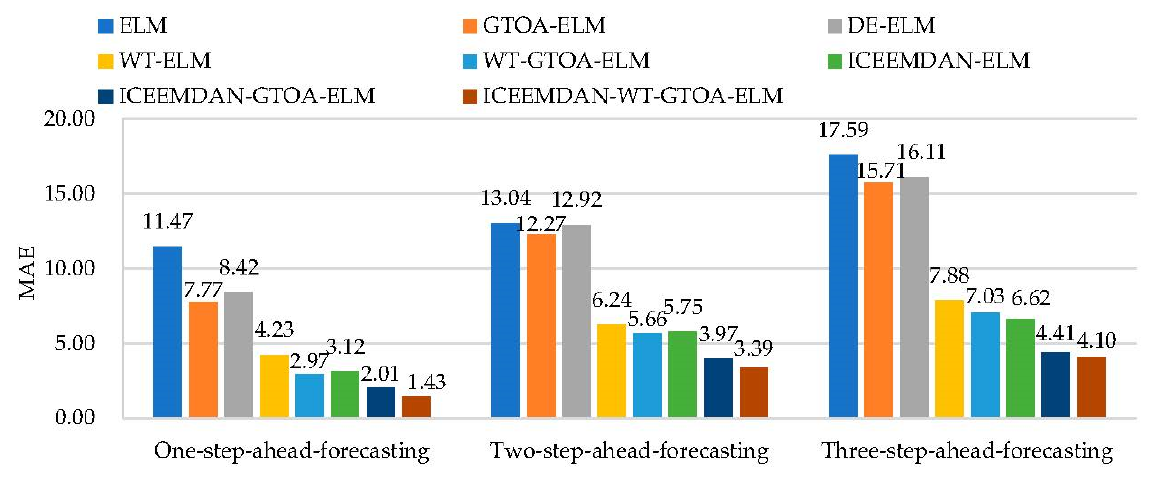
Figure 4. Mean absolute error (MAE) of PM10 forecasting.